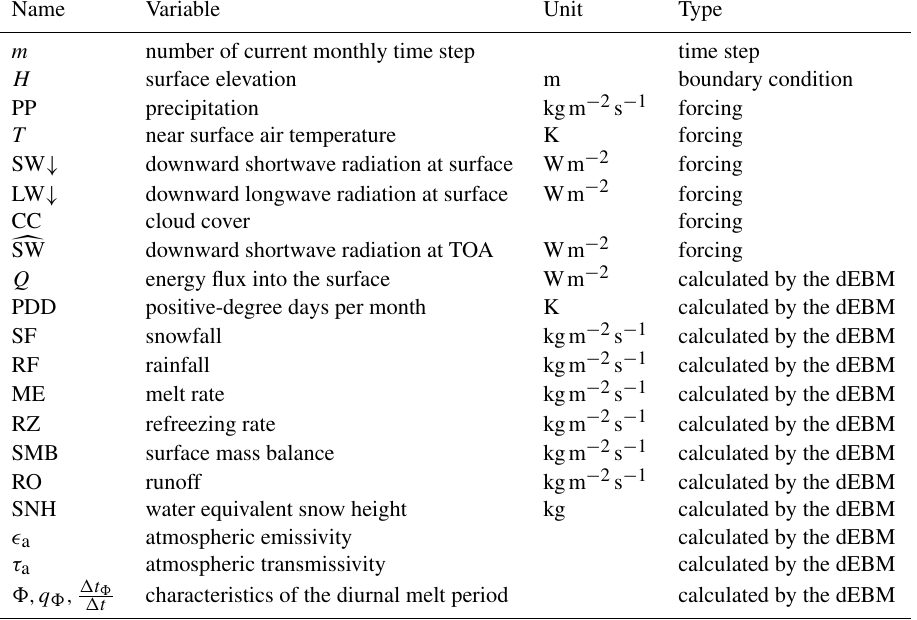
Table A1. Variables used in the dEBM.